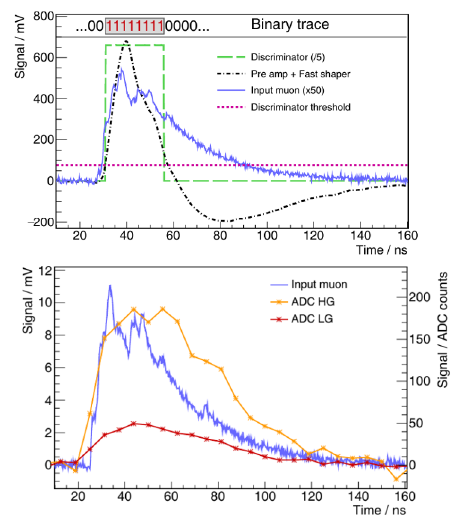
Figure 4. Two simulated single-muon signal at 2 m for the Counting mode (top) and for the Integrated signal mode (bot- tom). In the first case, the signal from the SiPM and the discrim- inator pulse are re-scaled for